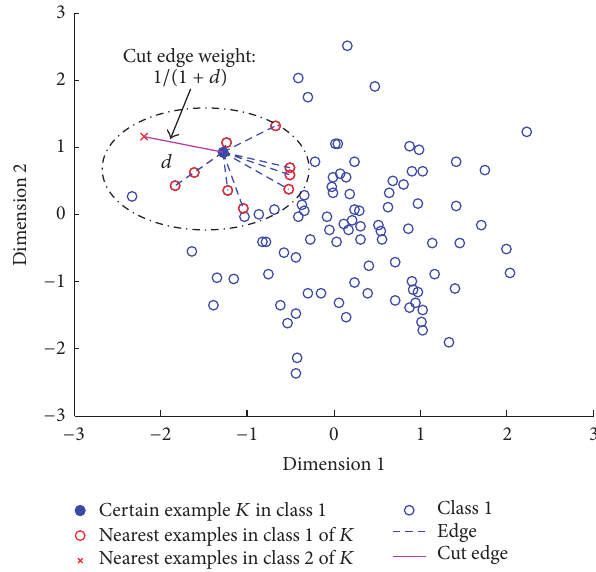
Figure 1: Cut edge